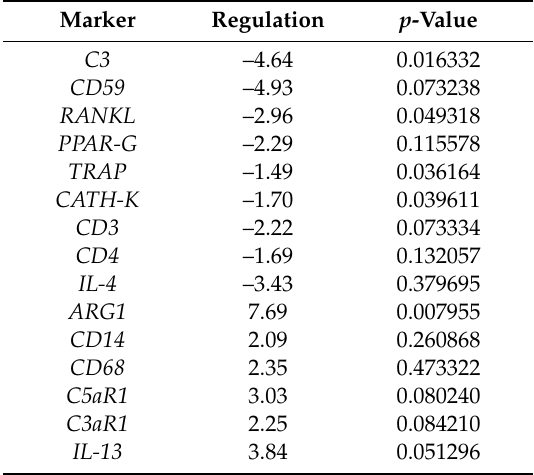
Table 5. Gene expression analysis of Cu compared to Ti (28 days).